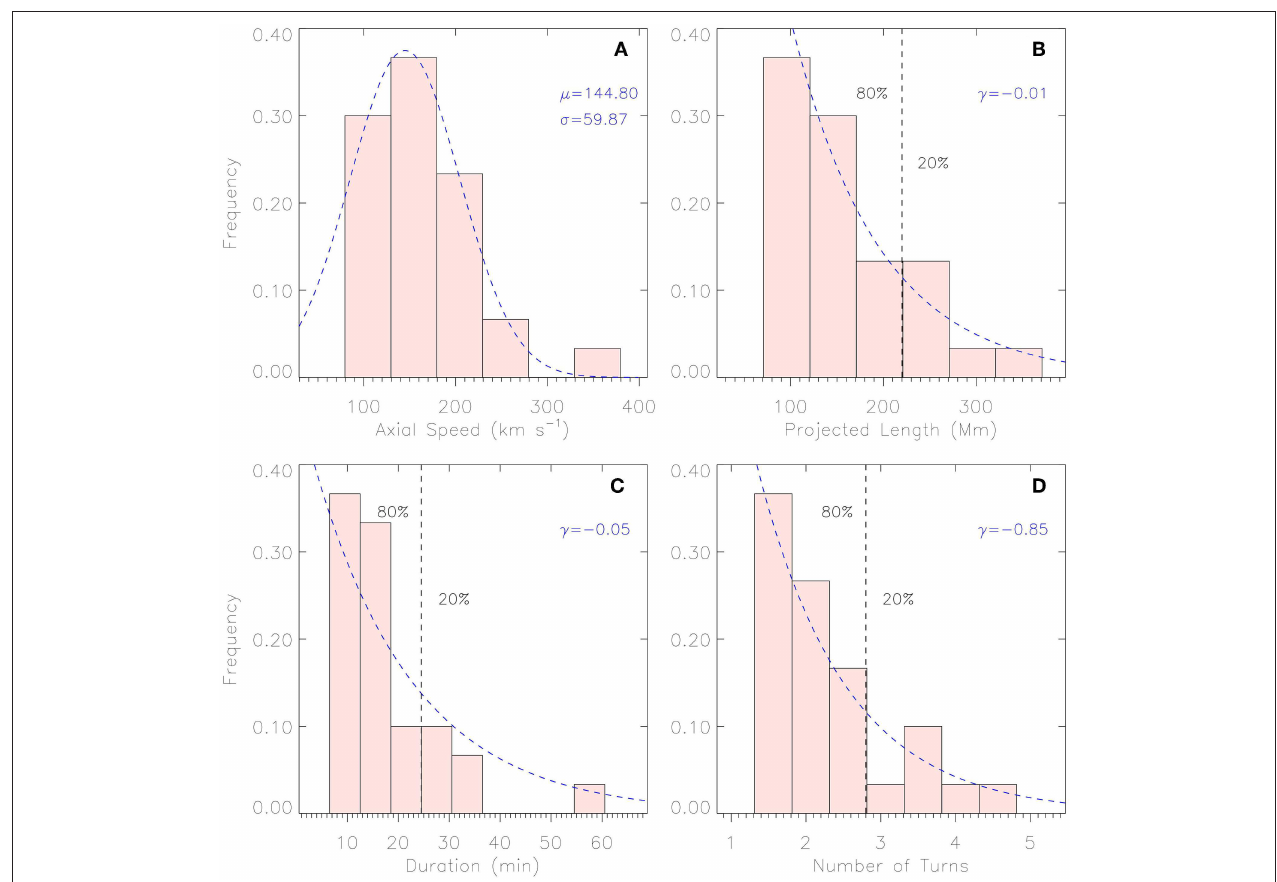
FIGURE 5 | Statistics of the average axial speed during the period of the rotational motion (A) , the projected length (A) , the duration of rotational motion (B) and the total number of turns (C) of all studied solar coronal jets. The blue dashed curve in (A) is the Gaussian fitting result. µ and σ are the arithmetic mean and standard deviation, respectively. Blue dashed curves in (B–D) are exponential fitting results. r is the exponential index. The integrated probabilities on the left of the black vertical dashed lines are